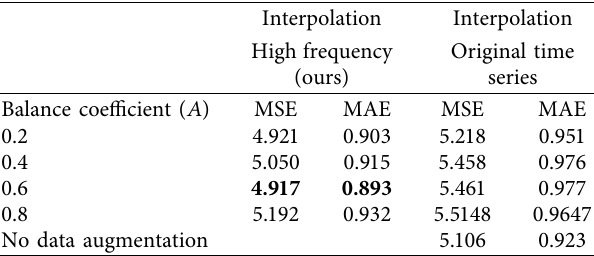
Table 4: Comparison experiments by applying interpolation with diverse balance coefficients to the high-frequency subseries and the original time